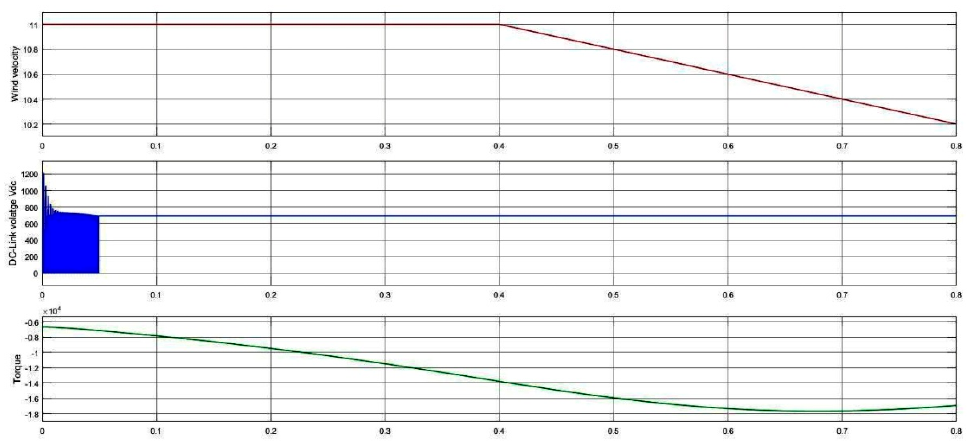
Figure 20. Waveforms for wind velocity variation, DC-Link voltage, torque.